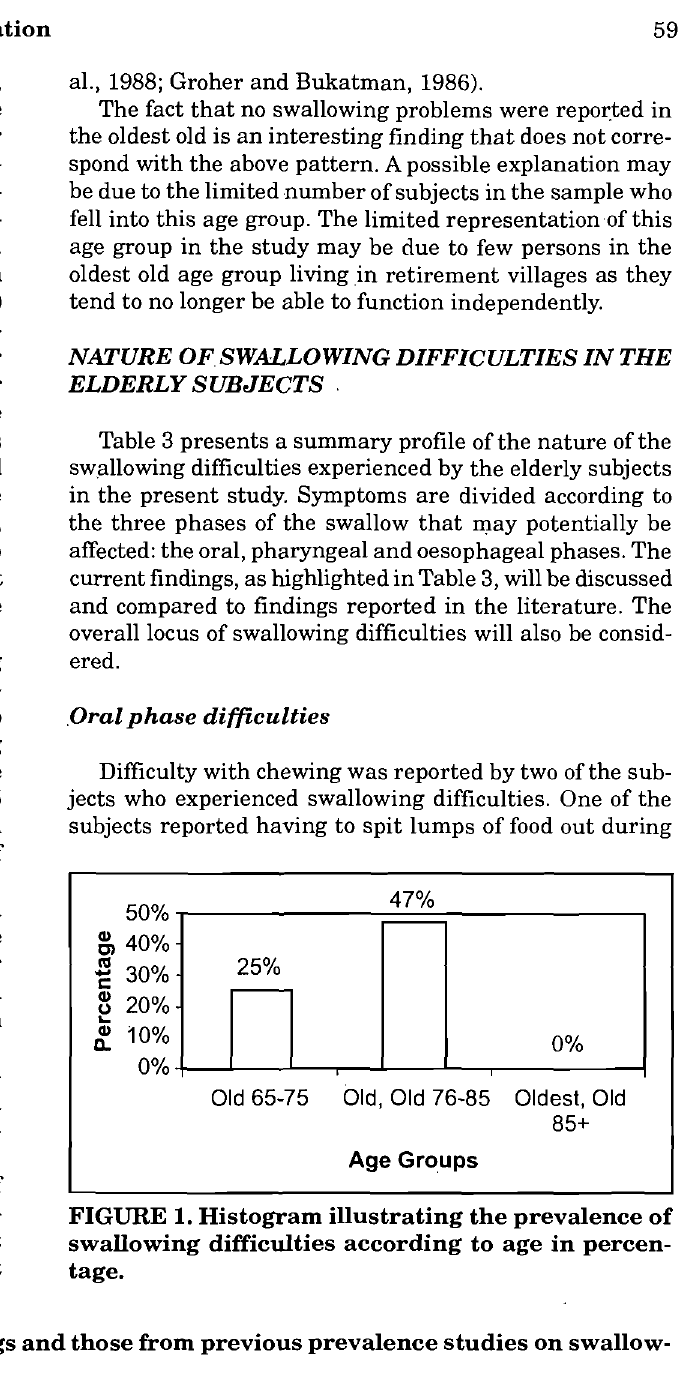
TABLE 2: A comparison between the current findings and those from previous prevalence studies on swallow ing disorders in the eld~rly